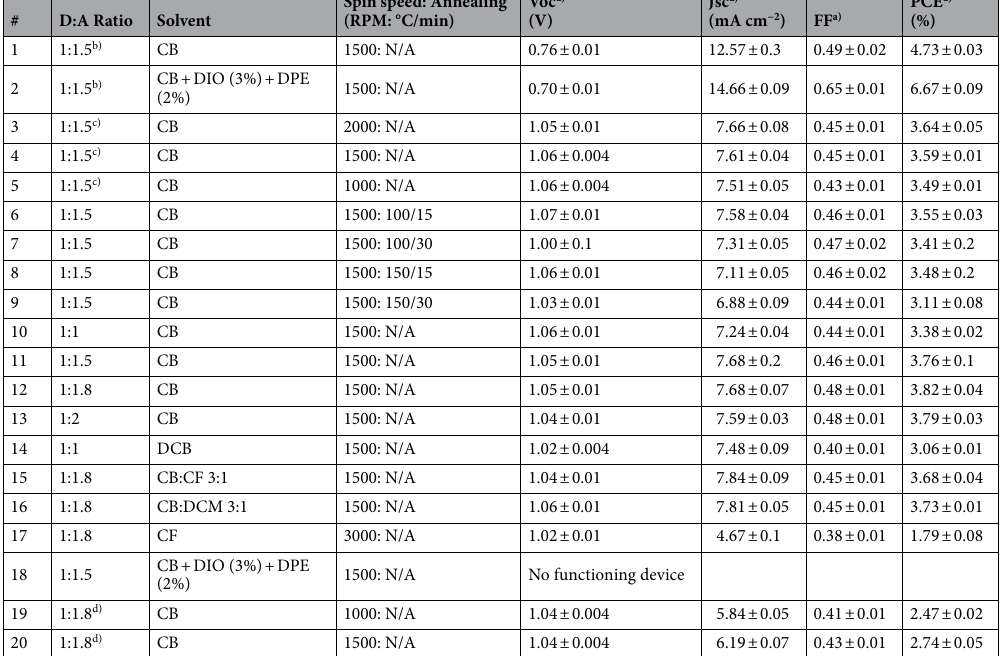
Table 1. Experimental conditions and resulting performance of PTB7:(3BS) 2 -SiPc BHJ OPV devices. a ) All BHJ OPVs were assessed under 1000 W m −2 light intensity, and scanned between − 2.0 and 2.0 V. The open circuit voltage ( Voc ), short circuit current ( Jsc ), fill factor (FF) and the power conversion efficiency (PCE) were obtained from an average of 4–8 devices with an individual area 0.32 cm 2 per device. Devices that have not been annealed are marked as “N/A”. b) Baseline device composed of PTB7:PC 61 BM at a 1:1.5 ratio. c) Solution was not filtered before deposition. d) PTB7 with M w of 96 kg mol −1 was used for all devices except device 19 and 20 where a M w of 16 kg mol −1 was